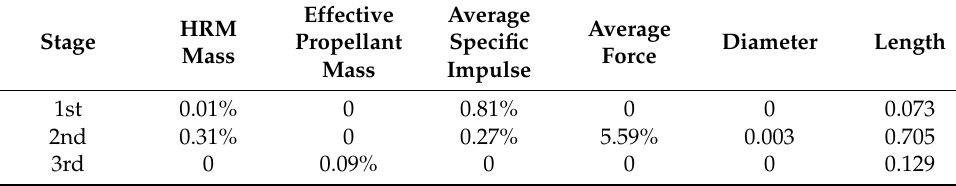
Table 6. System deviation values of ATC method.